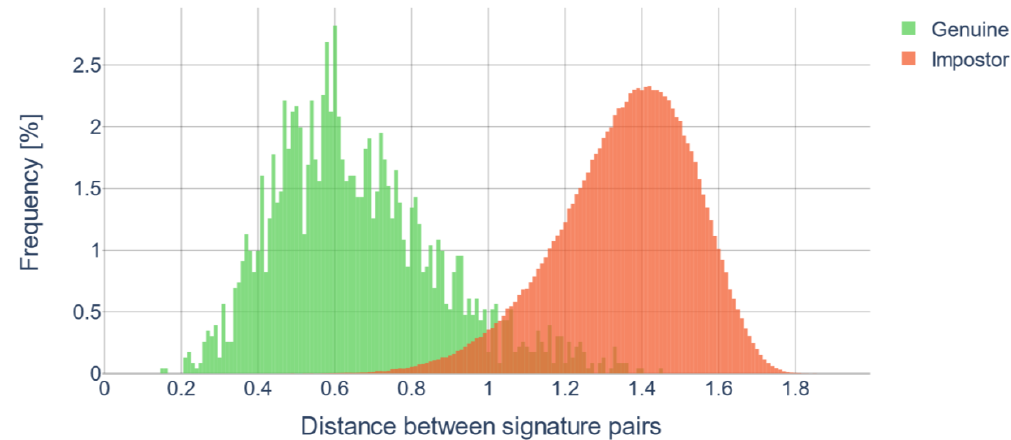
Figure 12. “ Genuine ” histogram shows the distribution of distances for pairs of signatures belonging to a single person, while “ Impostor ” depicts the distance distribution for pairs of signatures of different clients.